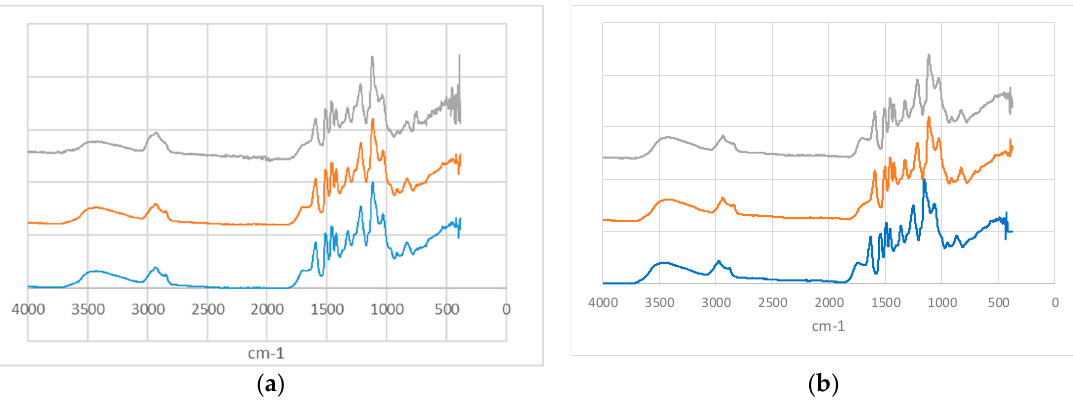
Figure 6. FT-IR spectra of ( a ) HOS-SE and ( b ) OS lignin isolated with 60% v/v ethanol, prior to homogenization (blue line), homogenized with 50% v/v ethanol (orange line) and 75% ethanol (grey line).